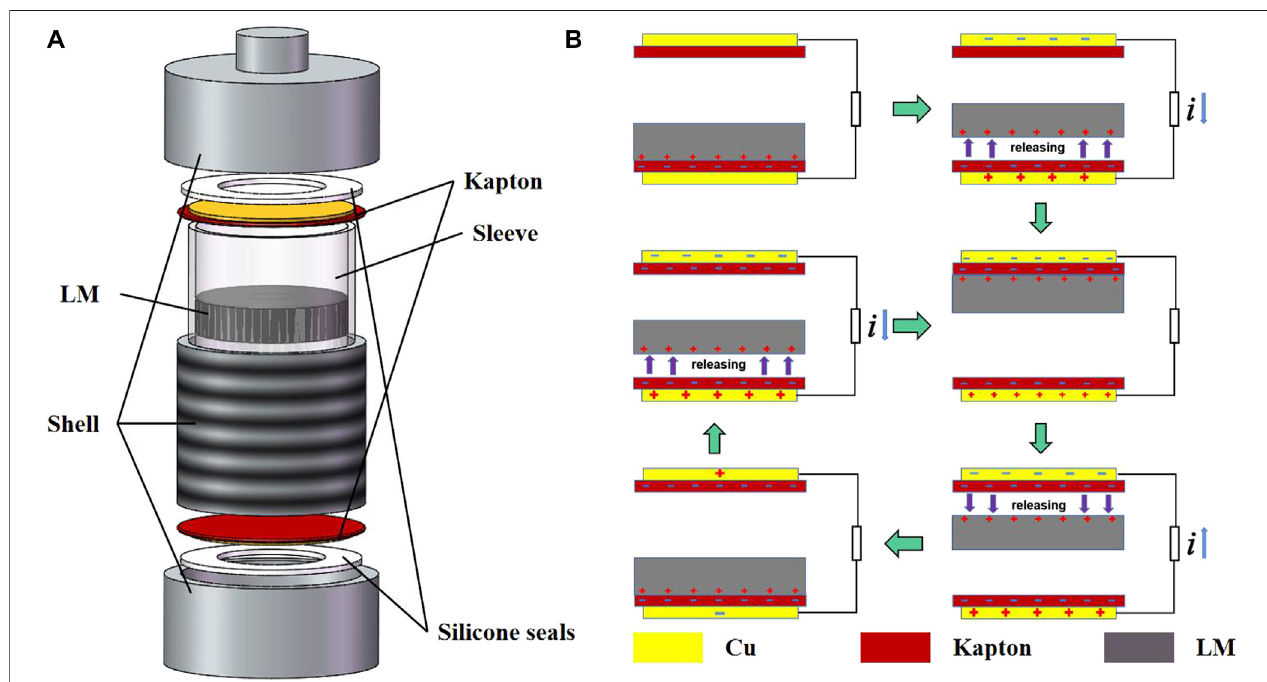
FIGURE1| WorkingprincipleofLM-FTG. (A) Schematicillustrationshowingthedevicecon fi gurationofLM-FTG; (B) step-by-stepillustrationshowingtheworking principle of LM-FTG.